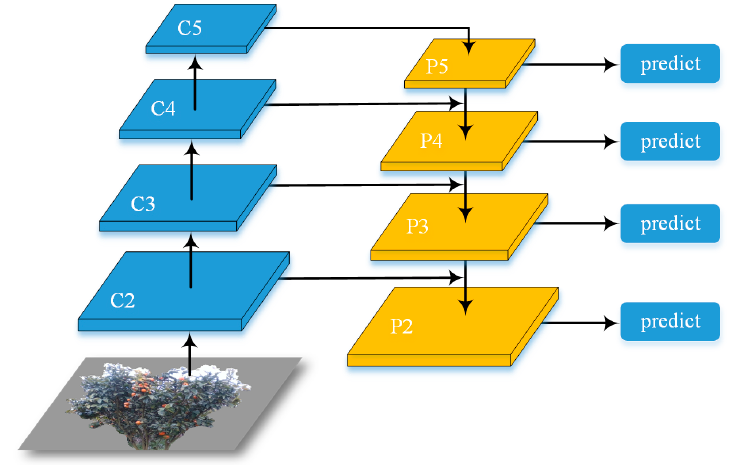
Figure 7. Feature pyramid network